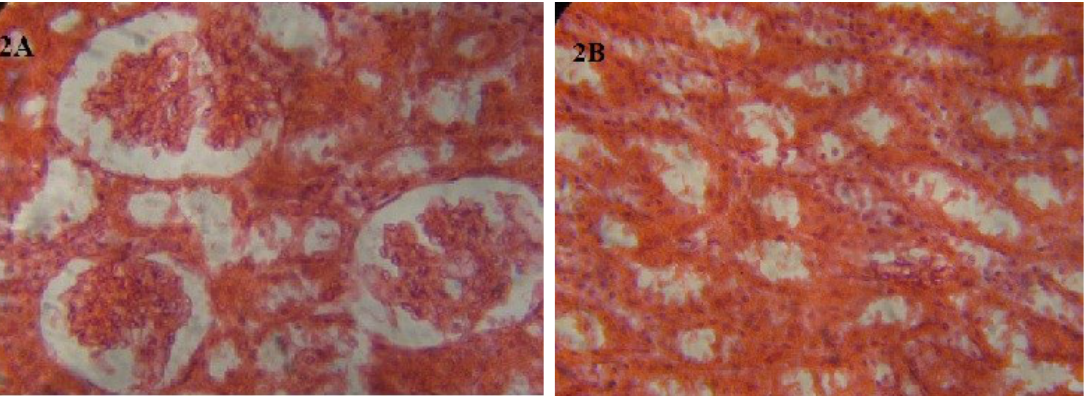
Figure 2: Microphotographs of Group C (control); (2A) renal cortex showed normal glomeruli and normal structures and (2B) renal medulla presenting normal distal tubules with a little hazy Measurement of serum potassium: Significant fall in serum potassium level in group G, as 3.4 ± 0.2 mEq/L was observed on last day of study period in comparison with group C (5.1 ± 0.2 mEq/L). Further, group GC-ze and C-ze were also observed to be significantly different from group G (5.1 ± 0.1 mEq/L and 5.2 ± 0.4 mEq/L vs 3.4 ± 0.2 mEq/L; Table II ). Measurement of serum calcium: Significant fall in serum calcium was observed in group G, as 7.7 ± 0.2 mg/dL on last day of study period in comparison with group C (9.7 ± 0.3 mg/dL). However, group GC-ze and C-ze were found significantly different from group G (10.0 ± Table II ). Measurement of urinary volume: Significant decrease in urinary volume of group G, as 126.0 ± 9.1 mL was observed in comparison with group C (217.0 ± 19.8 mL). mL) were also found significantly different from group G ( Figure 1B ).